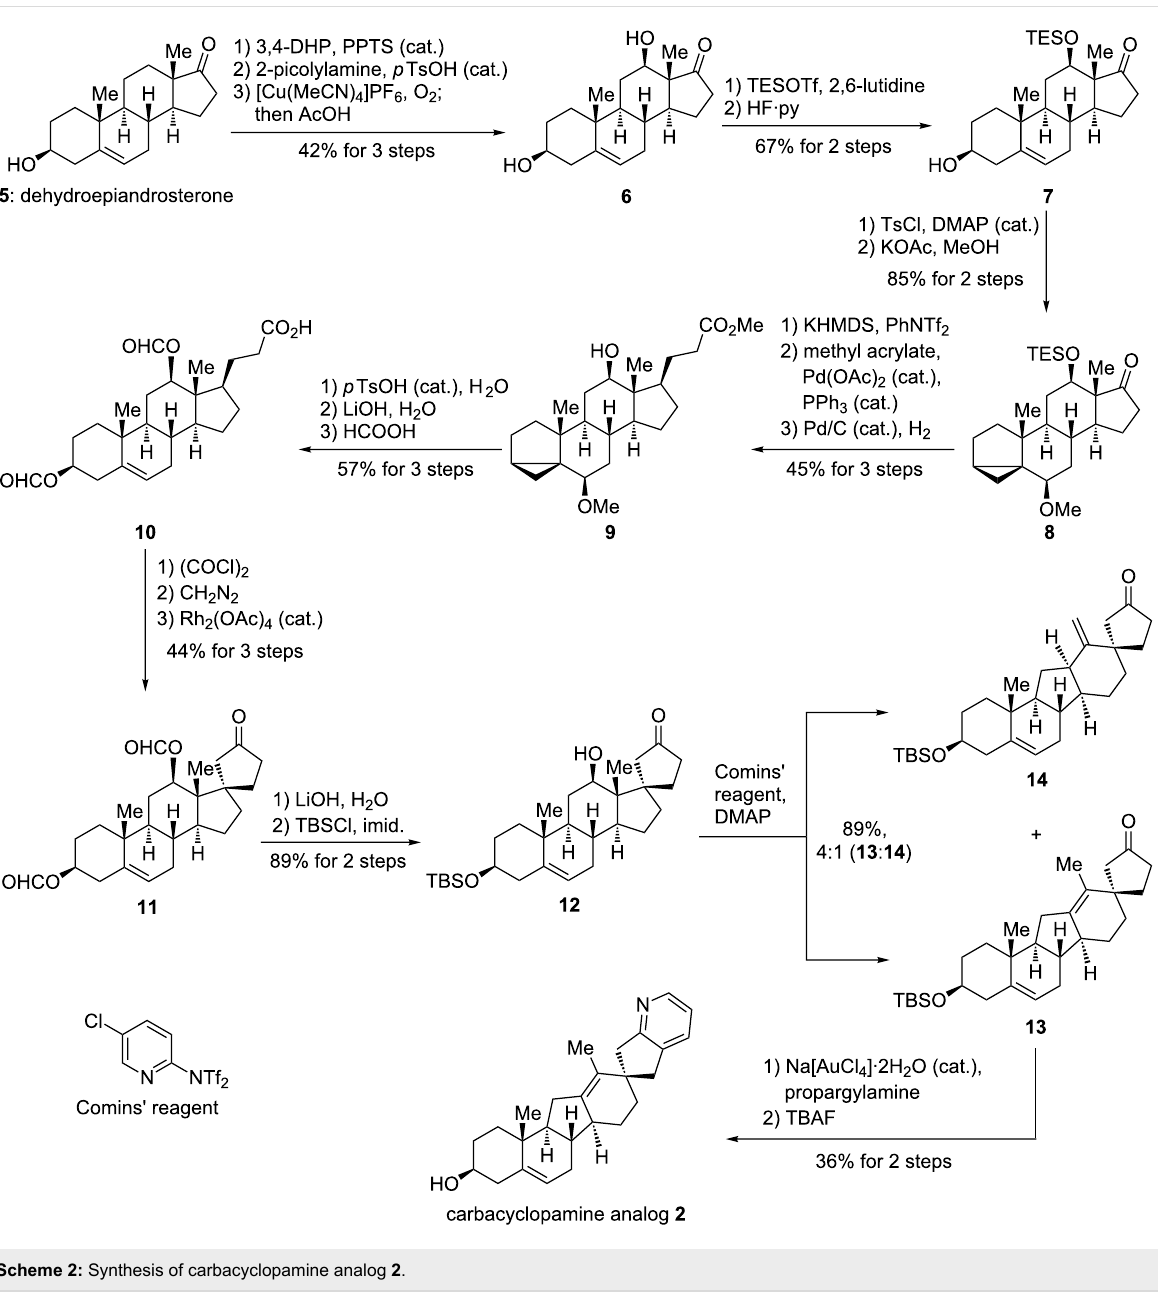
(2-picolylamine, cat. para -toluenesulfonic acid,